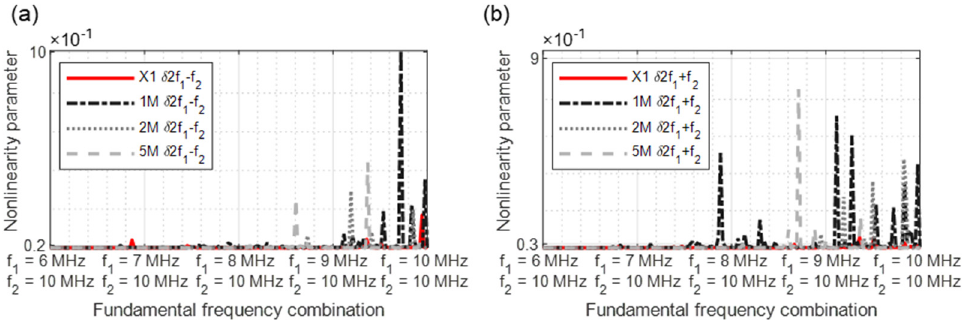
Figure 18. Nonlinearity parameter: ( a ) δ 2f 1 − f 2 ; ( b ) δ 2f 1 +f 2 .